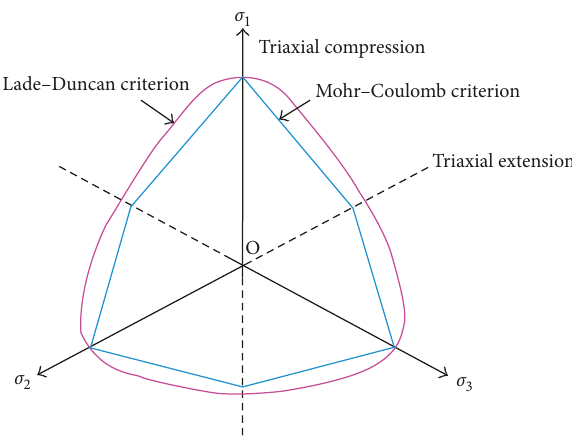
Figure 1: The Mohr–Coulomb and Lade–Duncan failure surfaces